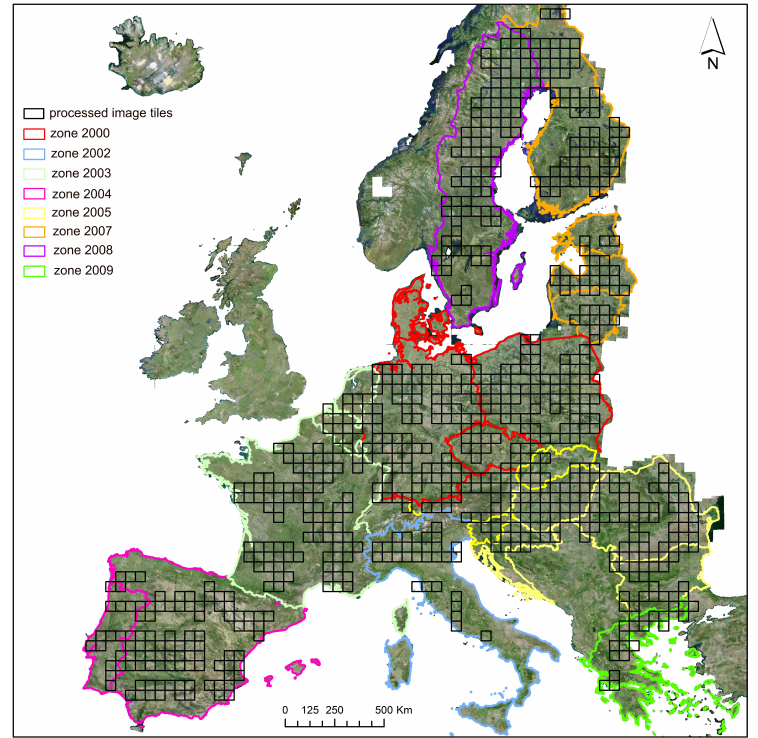
Figure 1. Copernicus very high resolution (VHR) mosaic with selected catchment characterization model (CCM2) zones in this work. Selected image tiles used in the processing in this paper are drawn as black light